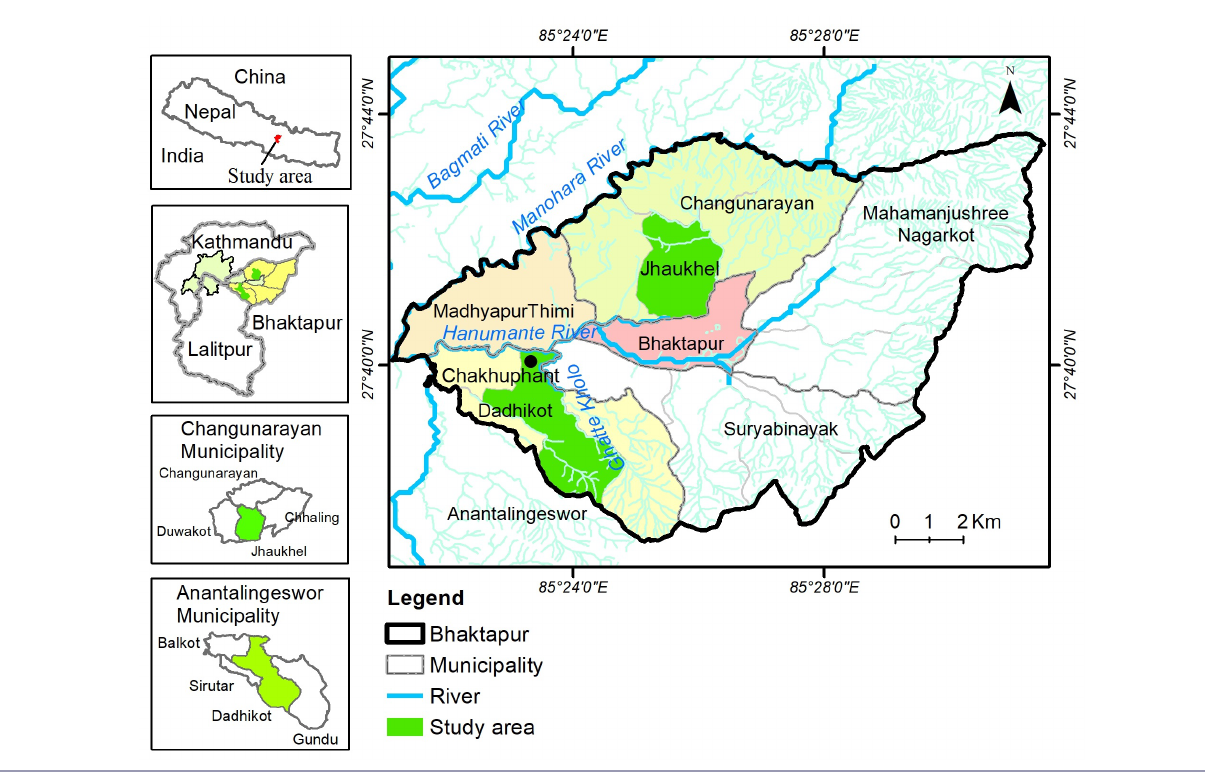
Fig. 1 . Location of study sites in Kathmandu